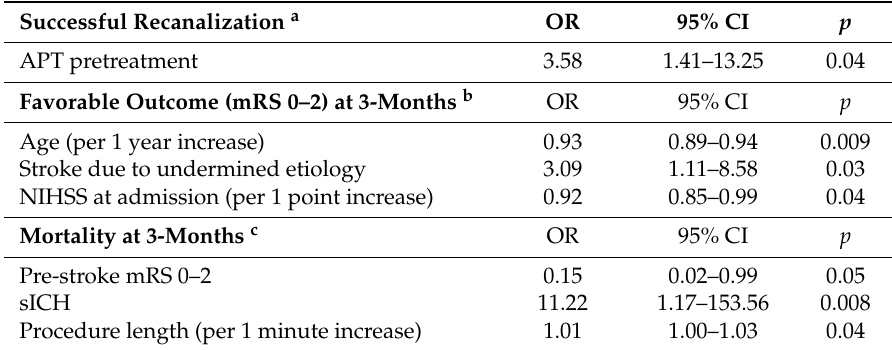
Table 4. Multivariable analyses showing the independent predictors of successful recanalization, favorable outcome at 3 months and mortality at 3